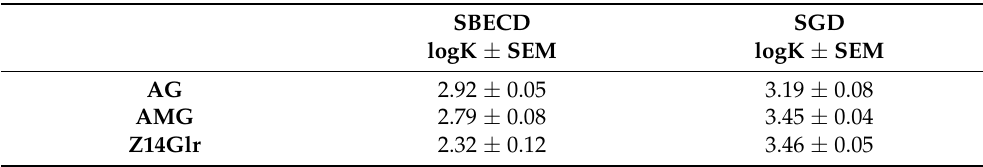
AG, alternariol - 3 - glucoside; AMG, alternariol - 9 - monomethylether - 3 - glucoside; Z14Glr, zeara - lenone - 14 - glucuronide; SBECD, sulfobutylether - β - cyclodextrin; SGD, sugammadex; SEM, standard error of the mean.